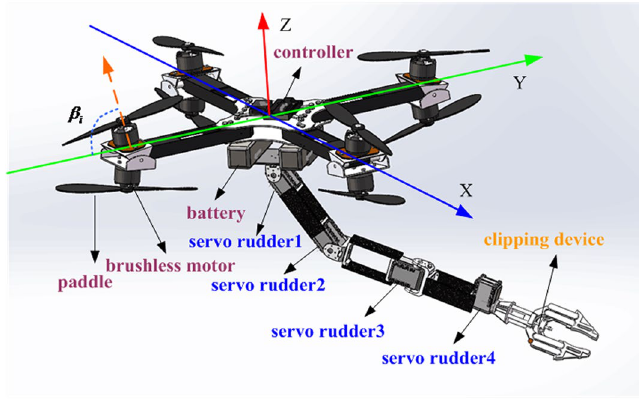
Figure 1. Structure of the fully-actuated AMS.